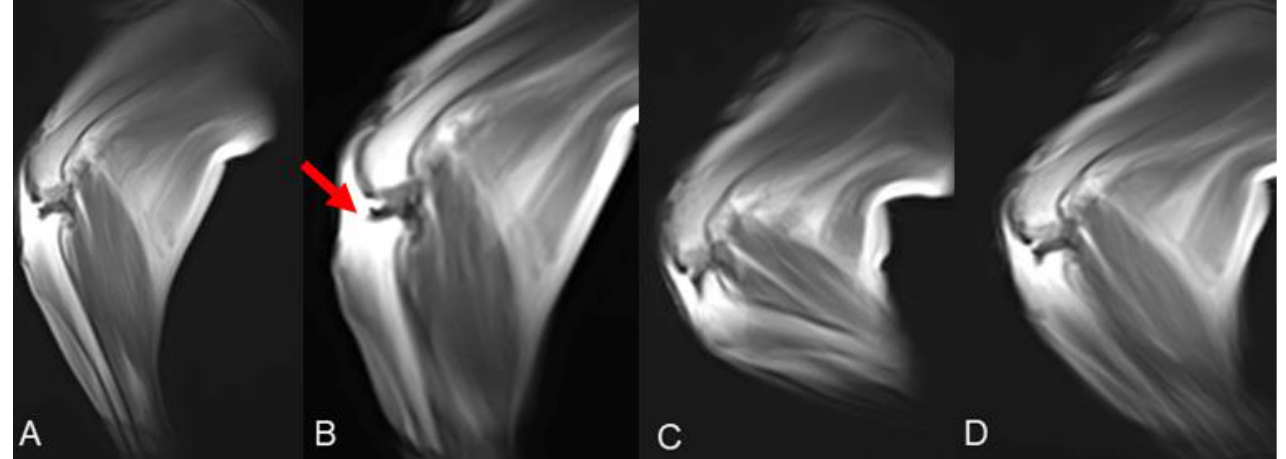
Figure 5. Case 6 stifle k-MRI sample images. (A) Starting position, normal femorotibial alignment. (B) TCT endpoint, cranial subluxation of the tibia is visible, due to surgical cranial cruciate ligament resection; (C) flexion and (D) extension movement, femorotibial, no subluxation visible.